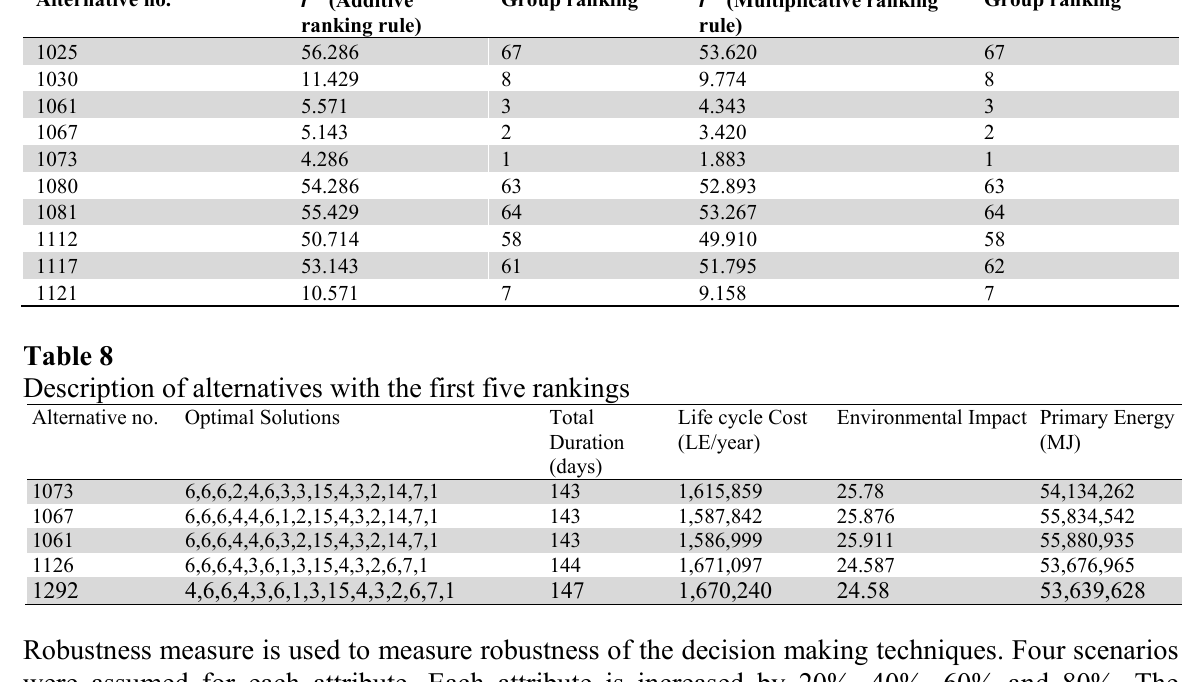
Ranking obtained from group decision making Alternative no.